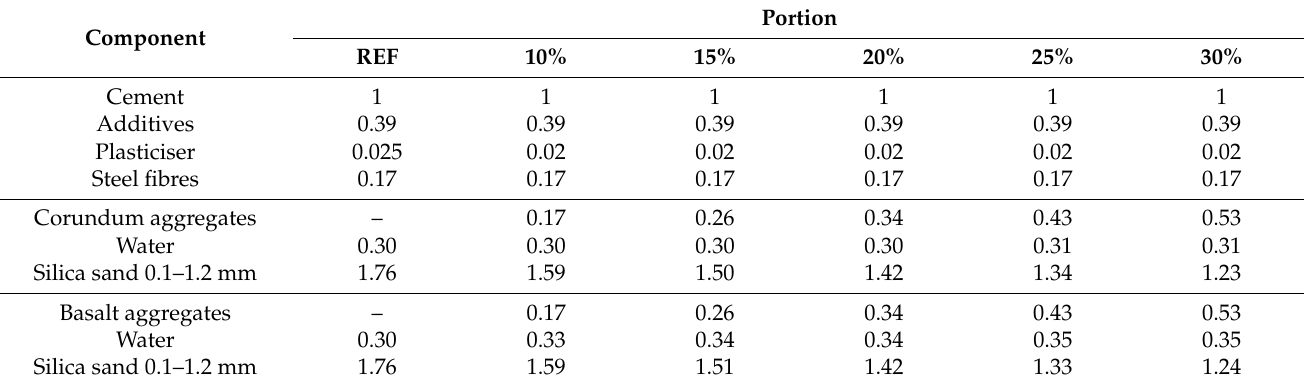
Figure 2. Basalt fraction 4–8 mm ( left ) and basalt fraction 0–2 mm ( right ). Table 1. Mix design with corundum and basalt aggregates. Table 1. Mix design with corundum and basalt aggregates.